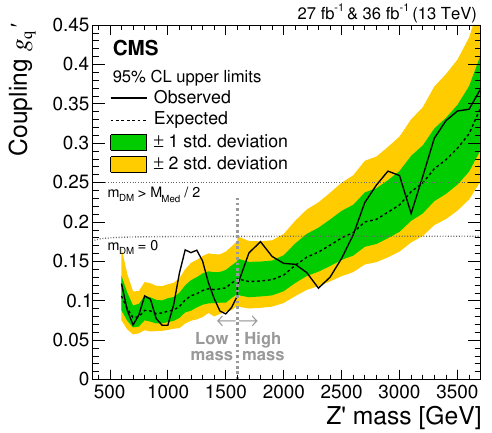
Figure 13 . The 95% CL upper limits on the universal quark coupling g 0 mass for a leptophobic Z 0 resonance that only couples to quarks. The observed limits (solid), expected limits (dashed) and their variation at the 1 and 2 standard deviation levels (shaded bands) are shown. The dotted horizontal lines show the coupling strength for which the cross section for dijet production in this model is the same as for a DM mediator (see